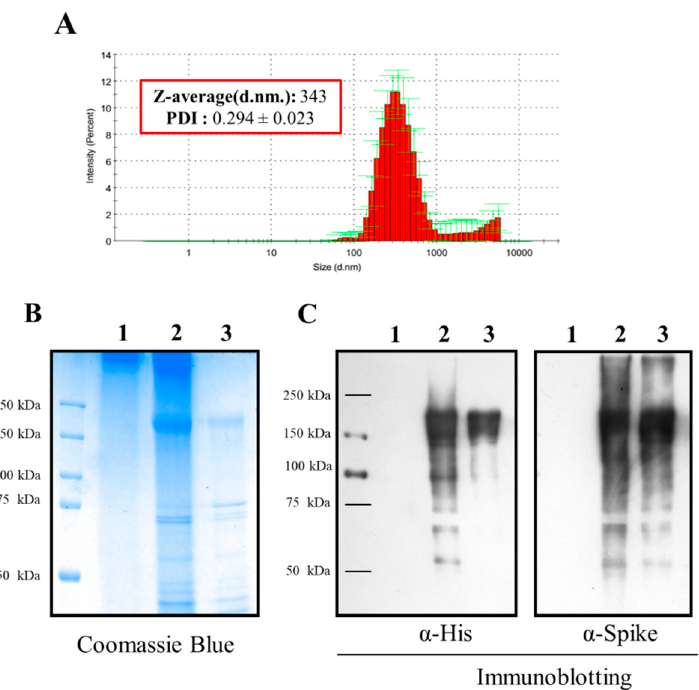
Figure 1. The physical characterization of S-TMC NPs. The ionotropic gelation method was used to encapsulate SARS-CoV-2 spike proteins into TMC NPs. After NP preparation, the mean particle size and polydispersity index (PDI) of the S-TMC NPs were evaluated by a zetasizer ( A ). The entrapment of S-protein in TMC NPs was determined by Coomassie blue staining ( B ) and immunoblotting using the anti-His tag and anti-SARS-CoV-2 RBD antibodies ( C ). 1: Empty TMC NPs; 2: S-TMC NPs; 3: soluble